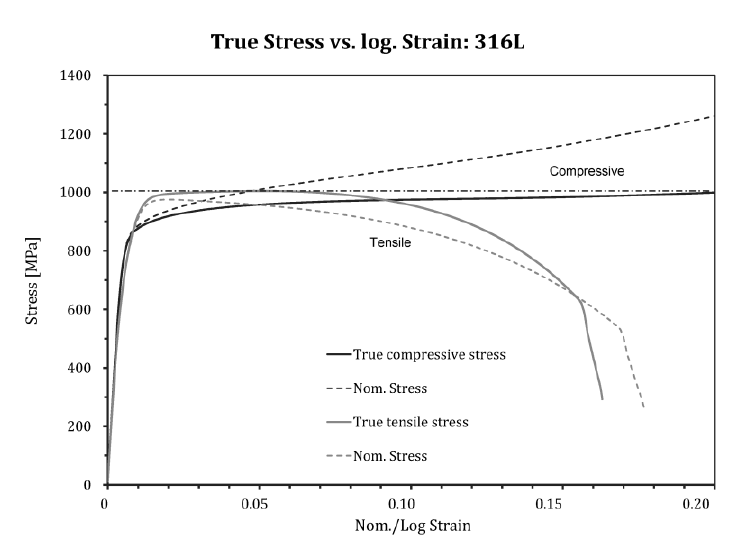
Figure 3. Test data displayed as True Stress vs. Logarithmic Strain.